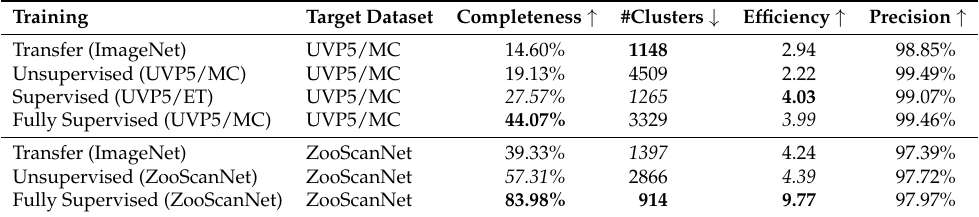
Table 3. Comparison of feature extractors regarding completeness, number of resulting clusters, efficiency, sorting precision and clustering runtime when using the previously selected configuration of HDBSCAN*. The best result for each respective target dataset is bold, the second best is